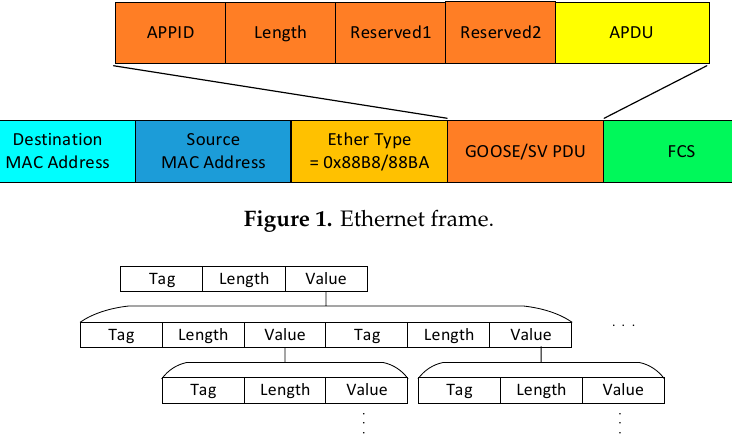
Figure 2. Basic Encoding rule followed by Tag, Length and Value (TLV).